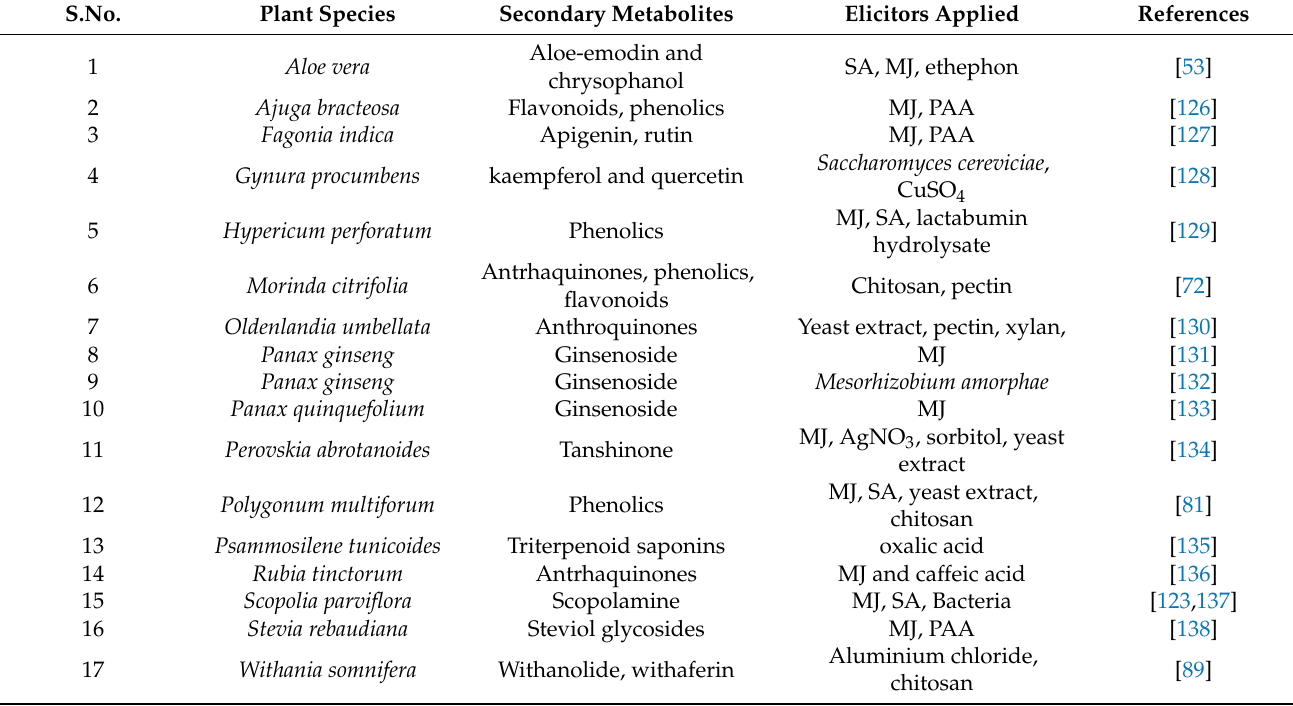
Table 2. List of medicinal plant species with applied elicitors in adventitious root